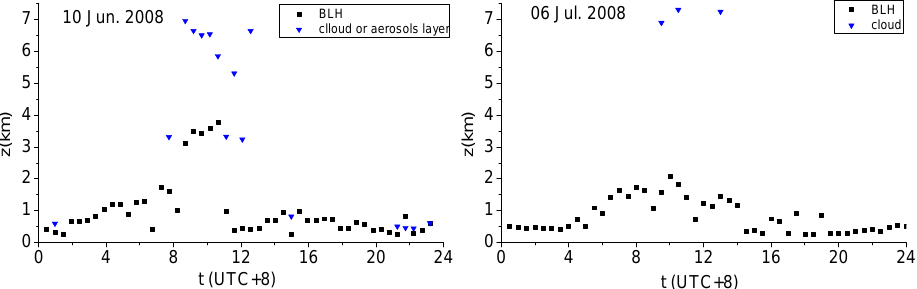
Fig. 3. The diurnal evolution of BLH on two days during summer of 2008. Each dot represents the average for five minutes measurements. Measurements were taken every Fig. 3: The diurnal evolution of BLH on two days during summer of 2008. Each dot 450 represents the average for five minutes measurements. Measurements were taken 451 every 30 min. 452